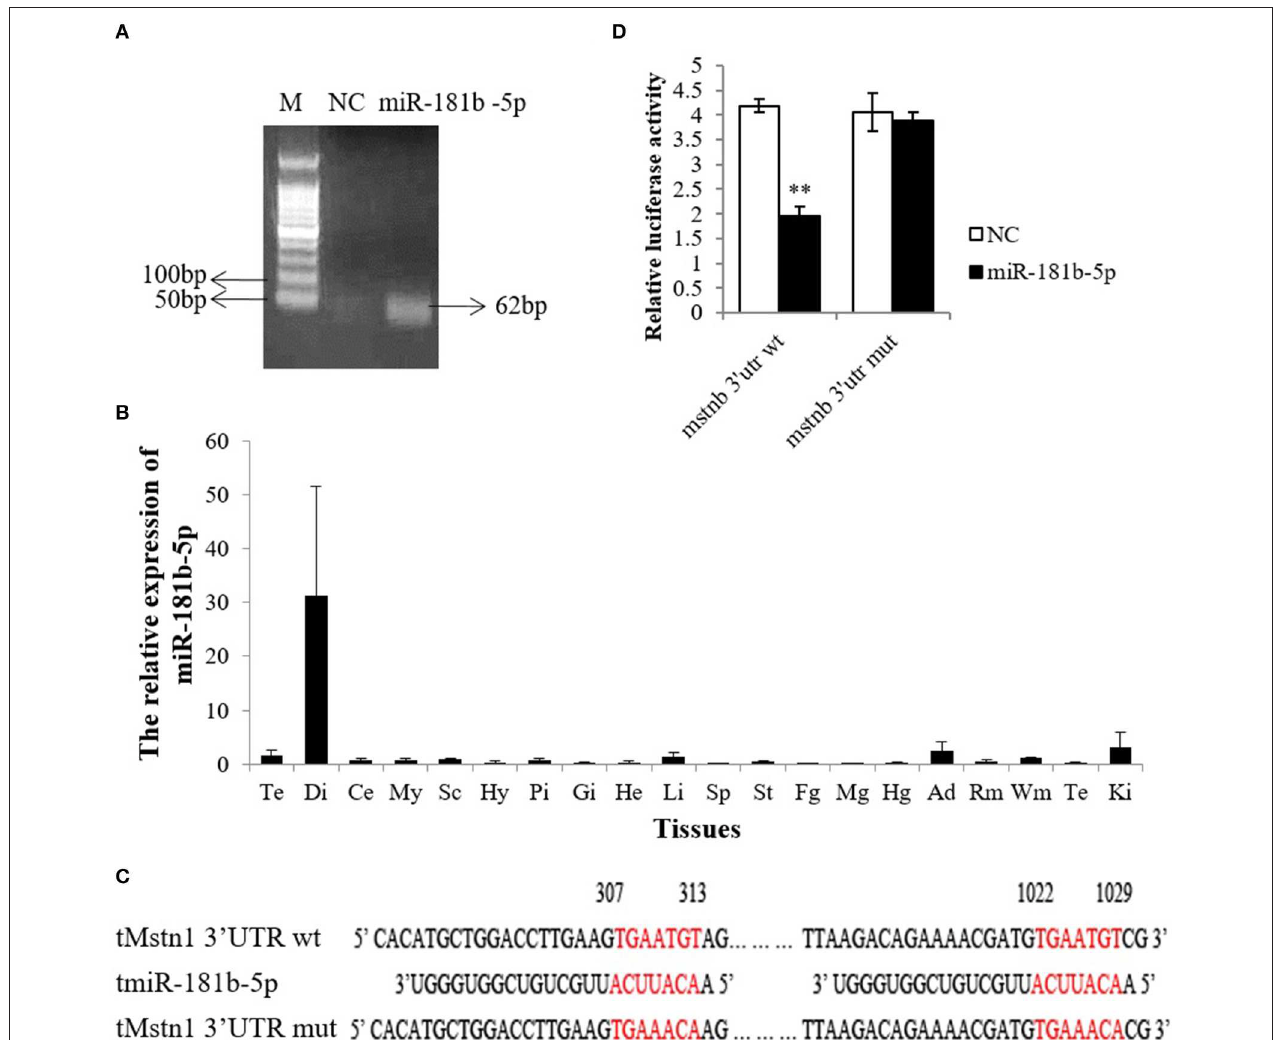
FIGURE 3 | miR-181b-5p directly targeted Mstnb 3 ′ UTR. (A) MiR-181b-5p clones were identified by PCR in tilapia brain. (B) Relative mRNA expression of miR-181b-5p in the tissues of tilapia ( n = 3, males). Te, telencephalon; Di, diencephalon; Ce, cerebellum; My, Myelencephalon; Sc, spinal cord; Hy, Hypothalamus; Pi, pituitary; Gi, gill; He, Heart; Li, Liver; Sp, spleen; St, stomach; Fg, foregut; Mg, midgut; Hg, hindgut; Ad, adipose tissue; Rm, red muscle; Wm, white muscle; Te, testis; Ki, Kidney. (C) Complete complementarity between Mstnb 3 ′ UTR and miRNA ( Mstnb 3 ′ UTR wt) and incomplete complementarity ( Mstnb 3 ′ UTR mut). (D)